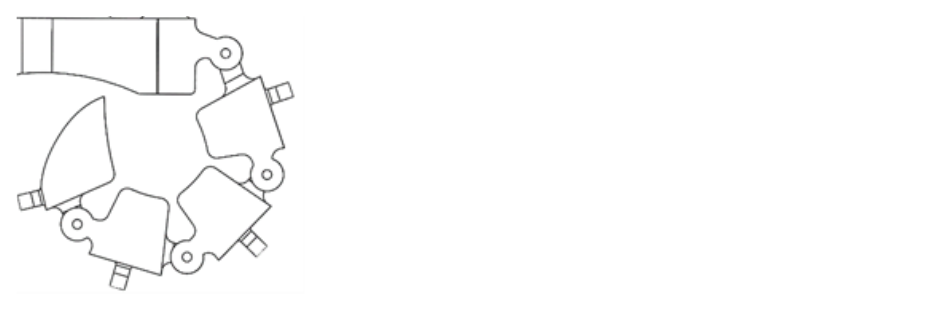
Figure 3. Maximum deformation result for the long claw toe of the articulated perch gripping mechanism.